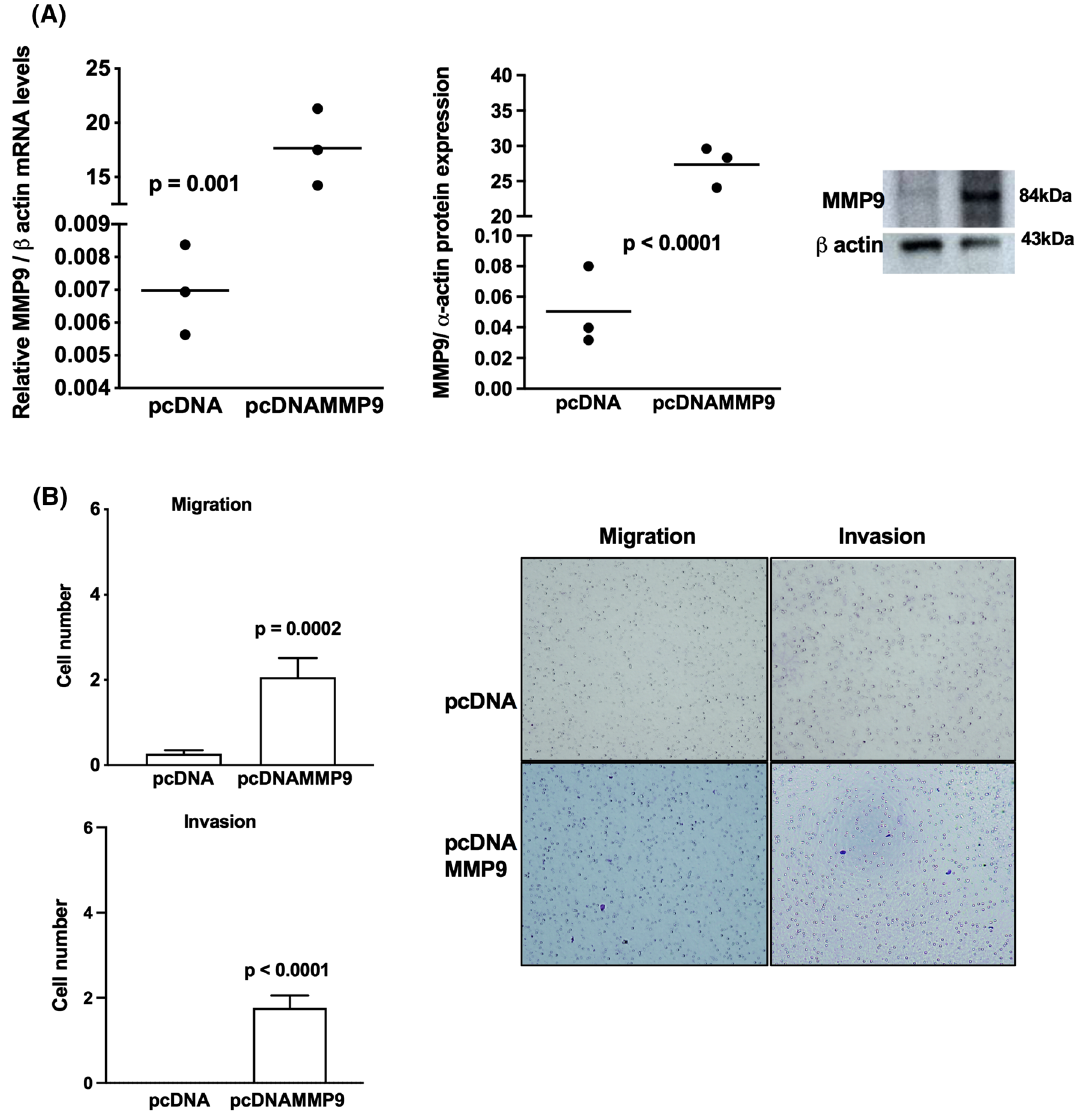
Fig. 10 Overexpression of metalloproteinase in adrenocortical adenoma cells. A MMP-9 expression in ACAPed-T7 transfected with pcD- NAMMP-9 and empty vector; representative immunoblot experiment of MMP-9; B migration and invasion assays in ACAPedT7 transfected with pcDNAMMP-9 and representative stained membranes. Magnification of membranes (100×). The experiments were performed in tripli- cate and repeated three times. The results were expressed as the mean ± SD. Statistical significance was assessed by unpaired t